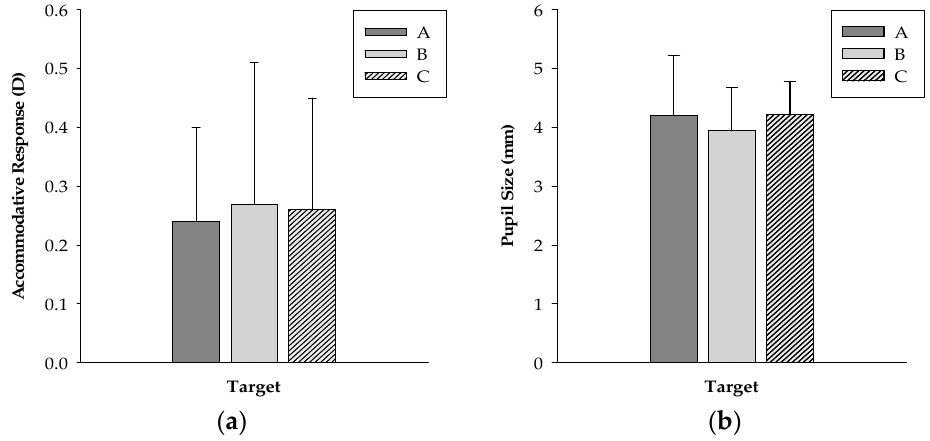
Figure 3. ( a ) Mean accommodative response; ( b ) Mean pupil size for targets A, B, and C.